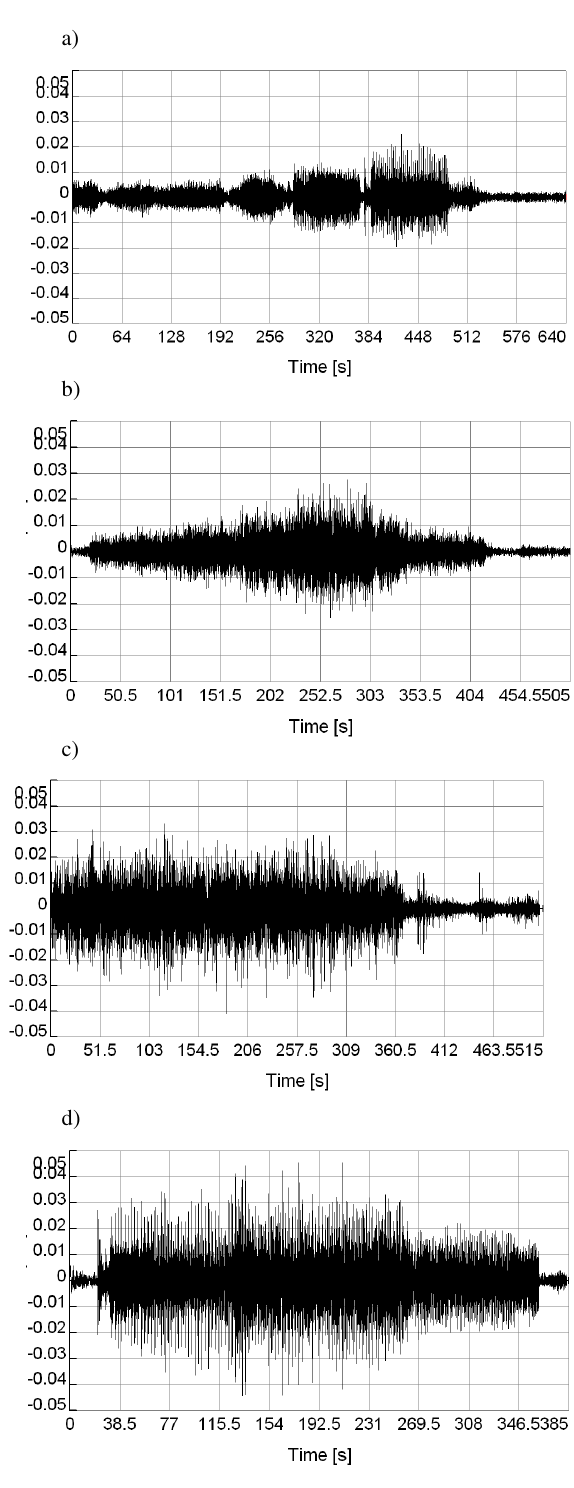
Fig. 7. The accelerograms obtained by using the 8 th sen- sor for different operating modes of the bells: a – the bells operate separately one after another; b – the bells operate all together; c – 4 smaller bells operate together; d – 2 biggest bells operate